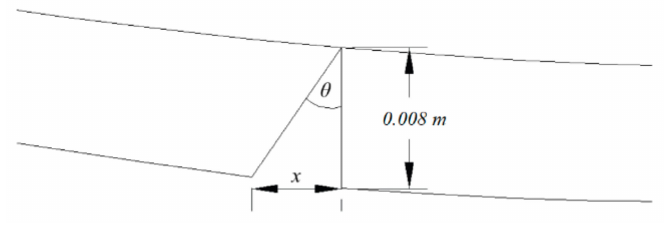
Figure 10. Case 4: Parameters of the articulated